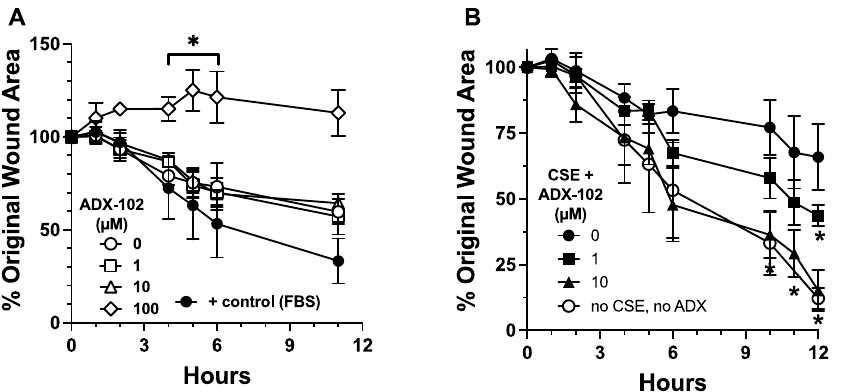
Figure 1. ADX-102 and bronchial epithelial cell viability. Medium release of lactate dehydrogenase (LDH) was measured and expressed as % viability in BEAS-2B cells ( A ) or LDH activity in 16HBE cells ( B ) after 24 h treatment with 0.1 µM to 10 mM ADX-102 in M-199 with 10% serum (Media). An equal number of cells were sonicated for maximum LDH release (Lysed). Positive assay control (+) was provided by a manufacturer. * p < 0.05 and ** p < 0.01 vs. 10 µM ADX-102; **** p < 0.0001 vs. 0–100 µM ADX-102. Bars represent SEM of biological n of three with three technical replicates. ns = not significant.